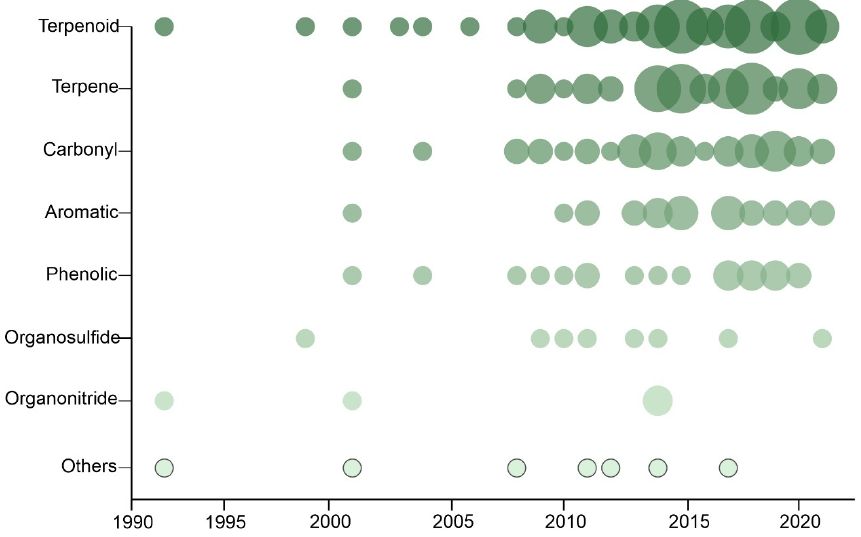
Figure 3. Scatterplot of number of articles with the chemical group published per year. The circle size is proportional to the number of articles published per year with each class of phytochemicals, and the circle color darkens with the largest overall number of articles published on each phytochemical. Plants 2023 , 12 , x FOR PEER REVIEW The 138 studies tested insecticidal phytochemicals on eight insect orders, focusing mainly on beetles (i.e., insects of the order Coleoptera; 42%), followed by butterflies and moths (i.e., Lepidoptera; 17%) and mosquitoes and other flies (Diptera; 16%). Compounds from 34 botanical families were studied. Lamiaceae, Asteraceae, and Rubiaceae were the most well-represented families, respectively (Figure 4). Overall, the studies were diverse and tested compounds originating from different families in the same insect order. Eighty-seven percent (87%) of the studies assessed phytochemicals belonging to the classes terpenoid, terpene, carbonyl, or phenolic. Out of these, 73% were terpenoids or terpenes, representing the focus of attention of such studies. The main insect orders studied were Coleoptera (43%), Diptera (17%), Lepidoptera (15%), and Psocoptera (13%), which correspond to 88% of the studies and encompass all phytochemical groups (Figure 5). Fumigation was the most frequent method of exposure observed in the studies screened, followed by topical application, contact, and, finally, ingestion. Fumigation was used for testing almost half of the analyzed substances (48%) and was present in 39% of the articles surveyed (Figure 6).